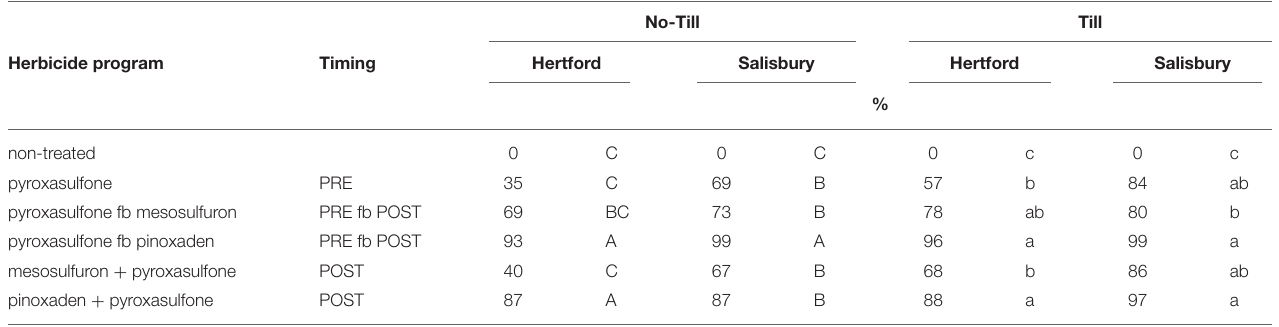
TABLE 4 | Italian ryegrass control in conservation and no tillage systems prior to winter wheat harvest as influenced by herbicide program and location averaged over years.